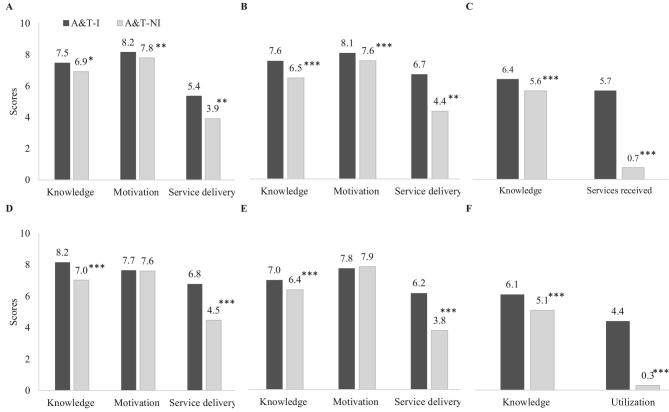
Performance measured at frontline worker and end-user levels, by program group, in Bangladesh and Vietnam. Bangladesh SK (A), Bangladesh SS (B), Bangladesh mothers (C), Vietnam HS (D), Vietnam VHW (E), and Vietnam mothers (F). *, **, ***Significant difference between intensive and non-intensive areas, accounting for geographic clustering: *P < 0.05, **P < 0.01, ***P < 0.001. A&T-I, Alive & Thrive–intensive; A&T-NI, Alive & Thrive–non-intensive; HS, health staff; SK, Shasthya Kormi; SS, Shasthya Sebika; VHW, village health worker.